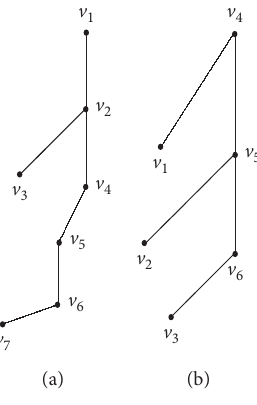
Figure 1: Trees for Remark